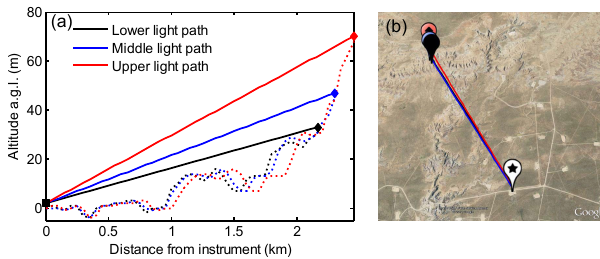
Figure 1. UCLA LP-DOAS system setup. The left panel shows the side view of the field setup, with the DOAS instrument represented by the solid square and the retro-reflector arrays represented by the diamonds. Light paths are shown in solid lines (lower in black, mid- dle in blue, and upper in red). Topography under each light path is shown in dashed lines of the same color. The right panel shows the top view of the light paths, with retro-reflectors located northwest of the DOAS instrument (white marker with black